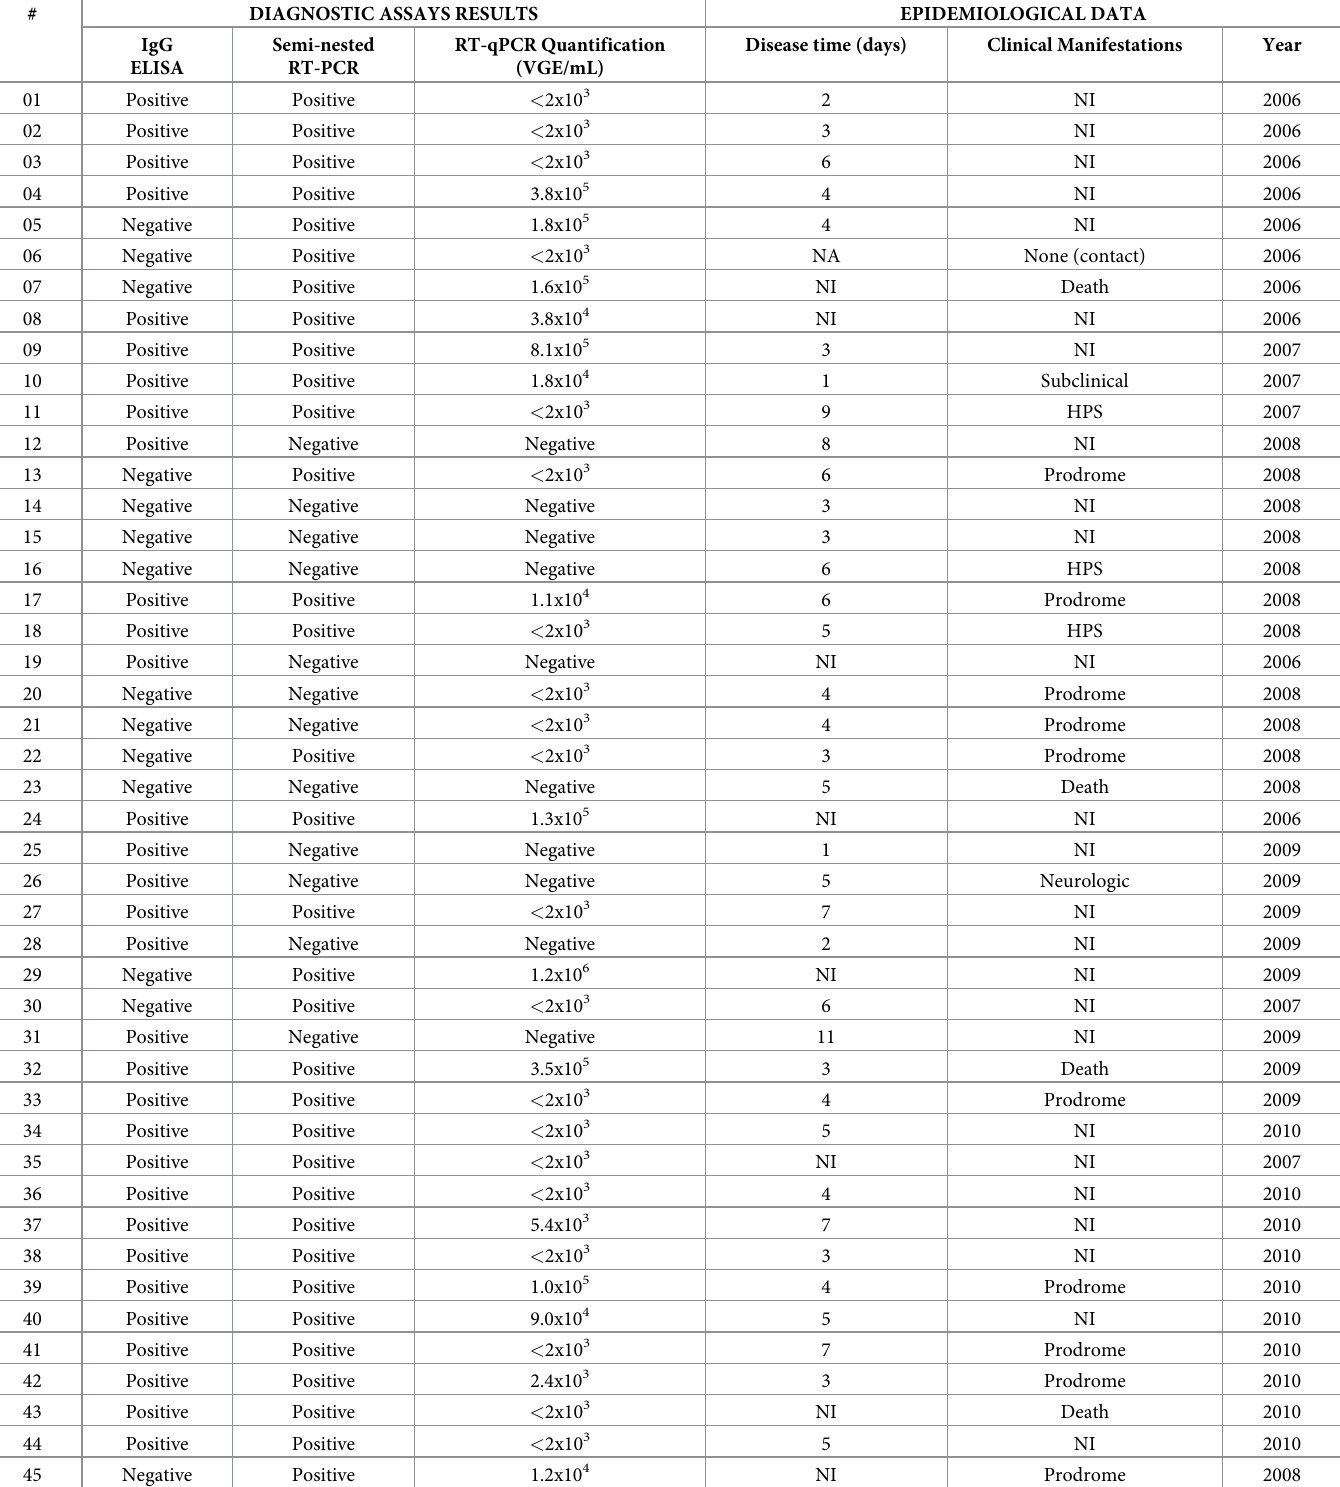
Table 4. Epidemiological data from hantavirus IgM-ELISA positive samples collected from symptomatic patients between 2003 and 2012 used in the clinical sensi- tivity/specificity